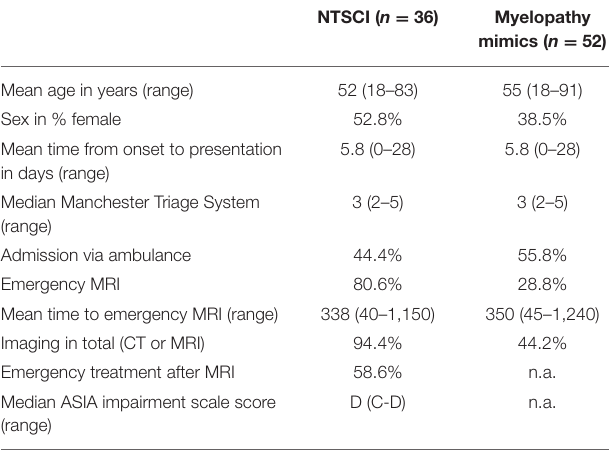
TABLE 1 | Demographical and clinical data of patients with NTSCI and myelopathy